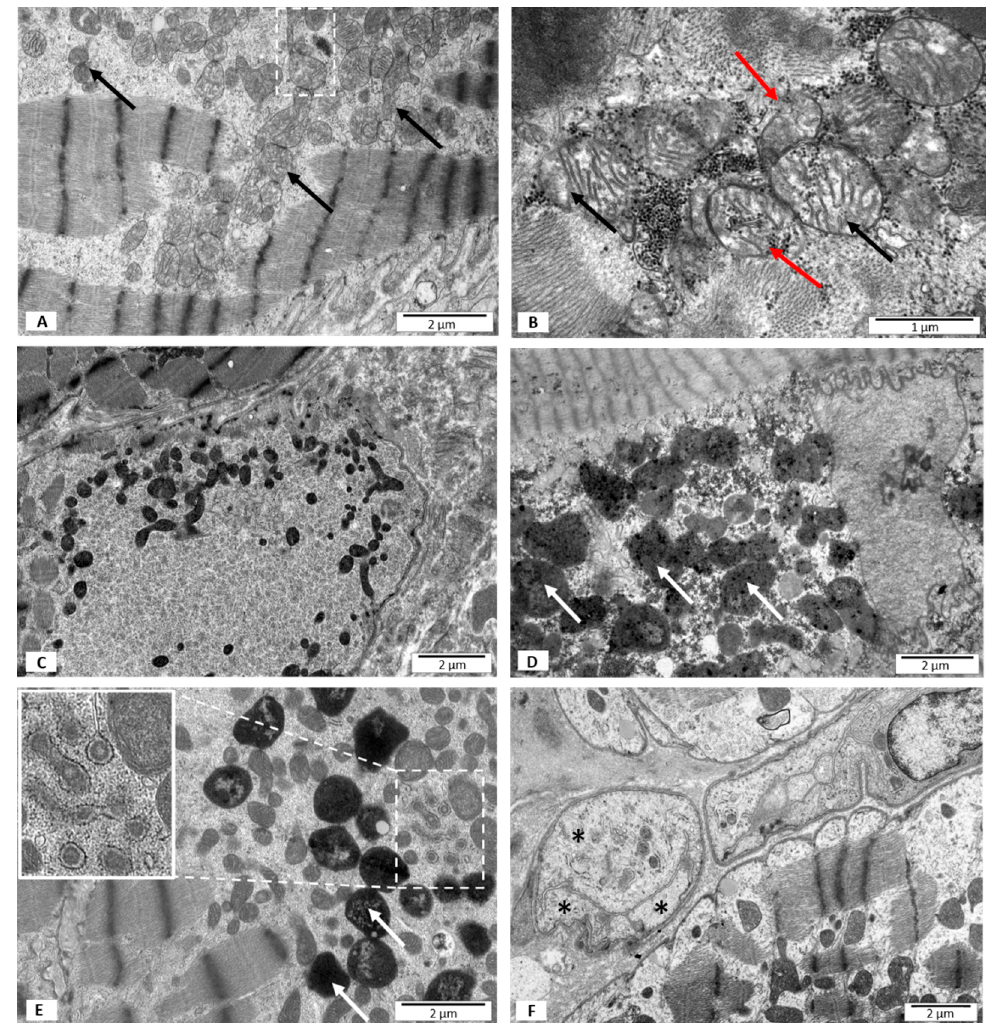
Figure 3. Electron microscopy images. Ultrastructural features of heart biopsies from patients with EF < 50% and PB19 virus detected. ( A ) A blurred structure of mitochondrial membranes marked with black arrows; mitochondria showing morphological features of fission marked with frame; ( B ) a disrupted outer mitochondrial membrane marked with red arrows; glycogen granules in the mitochondrial matrix are visible. Mitochondria showing morphological signs of swelling marked with black arrows; ( C ) increased electron density of the mitochondria; ( D , E ) high mitophagy rate; mitophagosomes marked with white arrows; ( E ) sarcoplasmic reticulum with the amorphous material marked with frame and shown in the insert; ( F ) blood vessel with features of necrosis marked with asterisks.